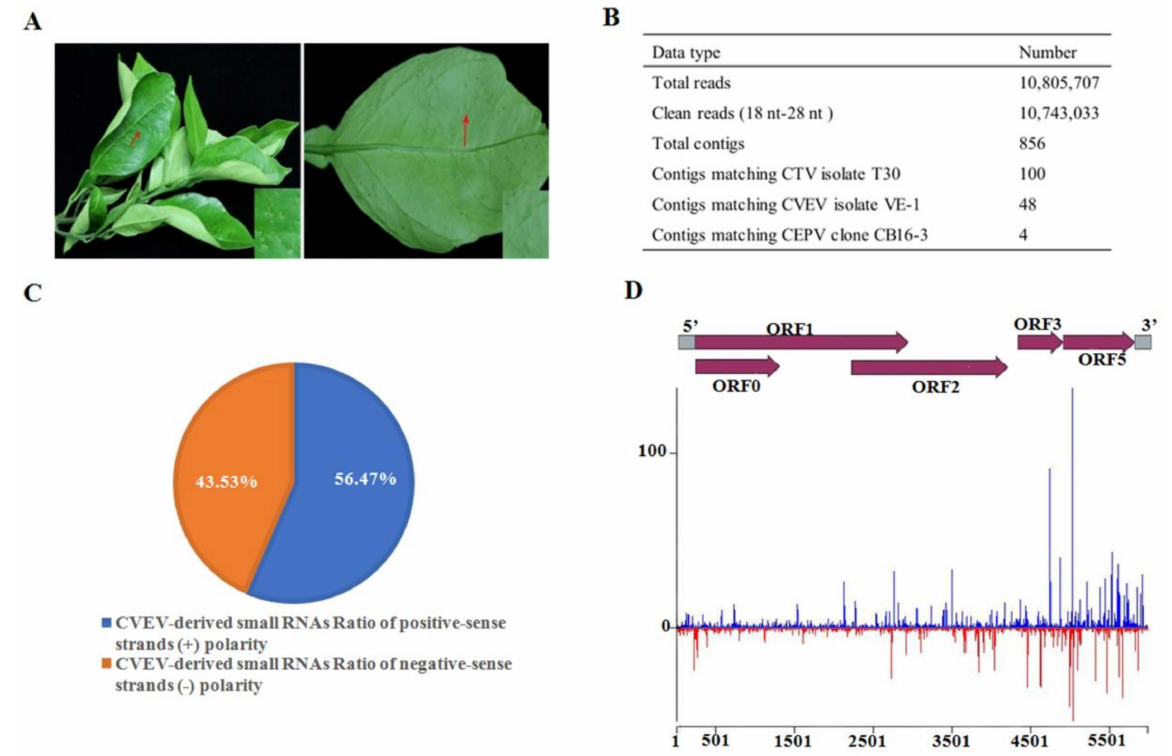
Figure 1. Identification of citrus vein enation virus (CVEV) and viral-derived siRNAs. ( A ) Typical symptoms represented in a leaf associated with vein enation disease. ( B ) Contigs assembly derived from sRNAs sequencing database. ( C ) Polarity distribution of vsiRNAs mapped to positive-sense or negative-sense CVEV genomic sequences. ( D ) Distribution of vsiRNAs along the CVEV-DT1